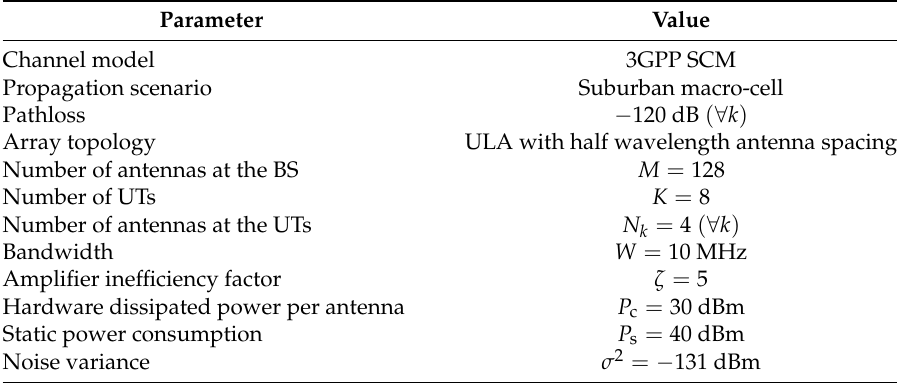
Table 1. Simulation Setup Parameters.